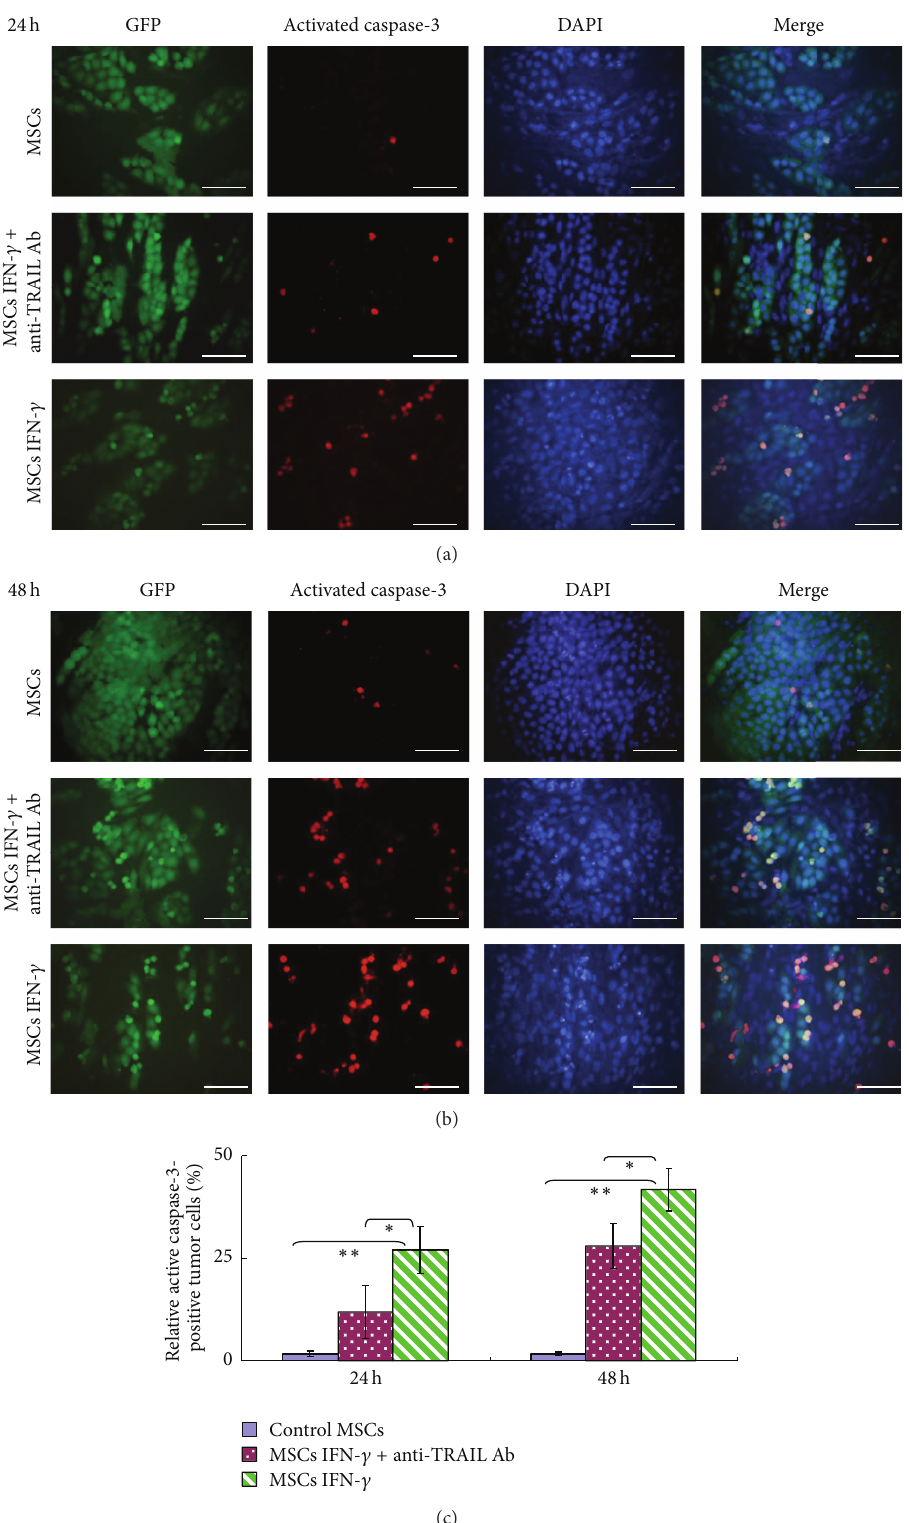
Figure 4: MSCs IFN- 𝛾 induced tumor cell apoptosis by activating caspase-3 within the target cells, a process which was mediated by TRAIL. MSCs IFN- 𝛾 were cocultured with H460 hrGFP cells for 24h (a) and 48 h (b) in the presence or absence of an anti-TRAIL antibody. The activated caspase-3 was detected in the H460 hrGFP cells by immunofluorescence staining. (c) The percentage of activated caspase-3-positive H460 hrGFP cells was quantified using ImagePro 5.0 ( ∗ 𝑃 < 0.05 , ∗∗ 𝑃 < 0.01 ). The reported results are representative of the results from three separate